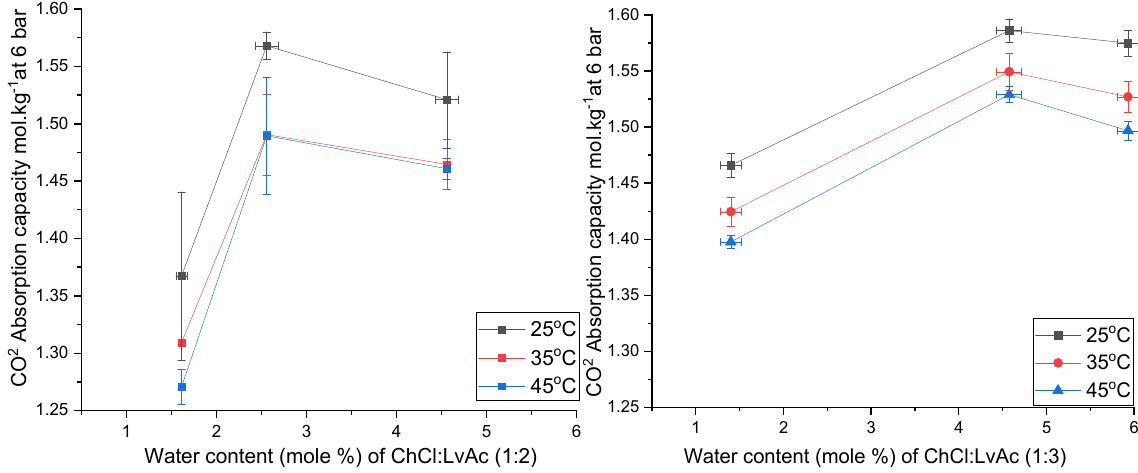
Figure 8. The effect of water content on the CO 2 absorption capacity of ChCl:LvAc (1:2) ( left ) and (1:3) ( right ) at 6 bar and at different temperatures.